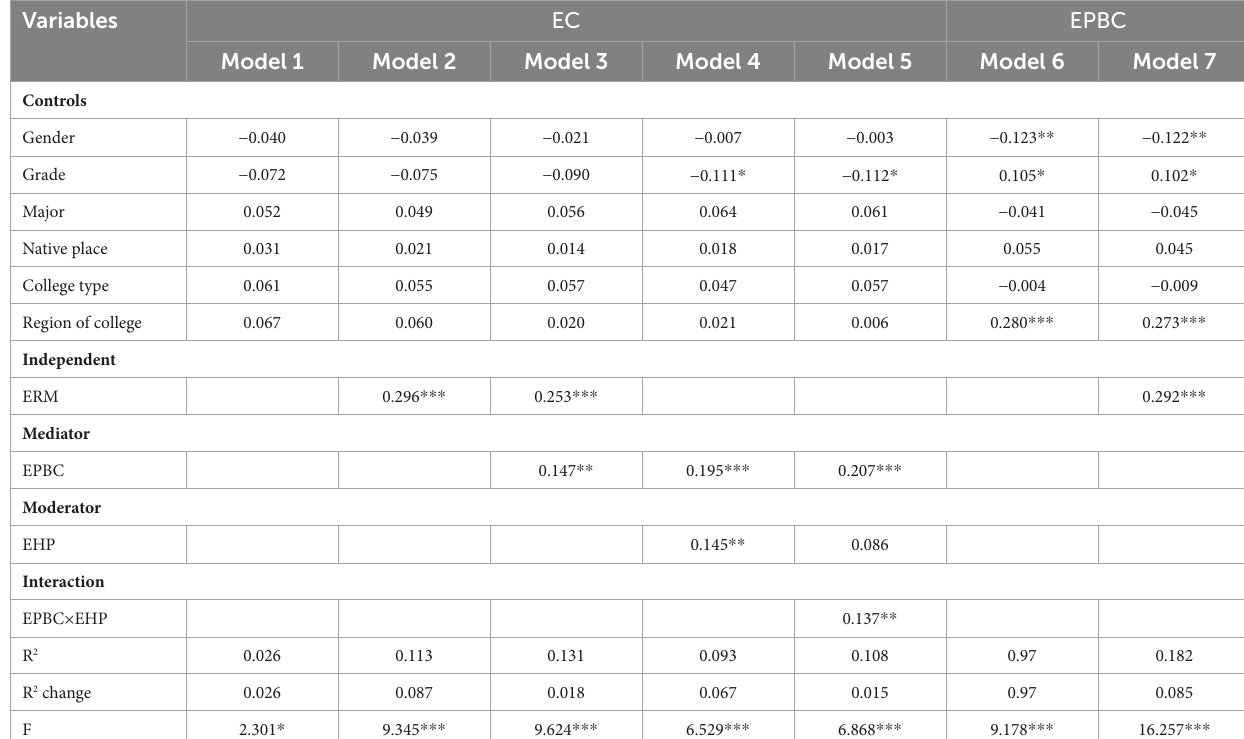
TABLE 5 Hierarchical linear regression analysis